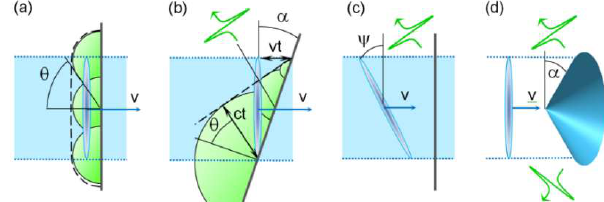
Fig. 1. Concept of using coherent transition radiation (CTR) for detection of ultrashort electron bunches. (a) For normal incidence, no emission is observed because of destructive interference .